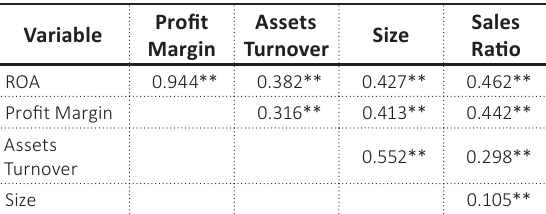
Table 4. Spearman correlation matrix